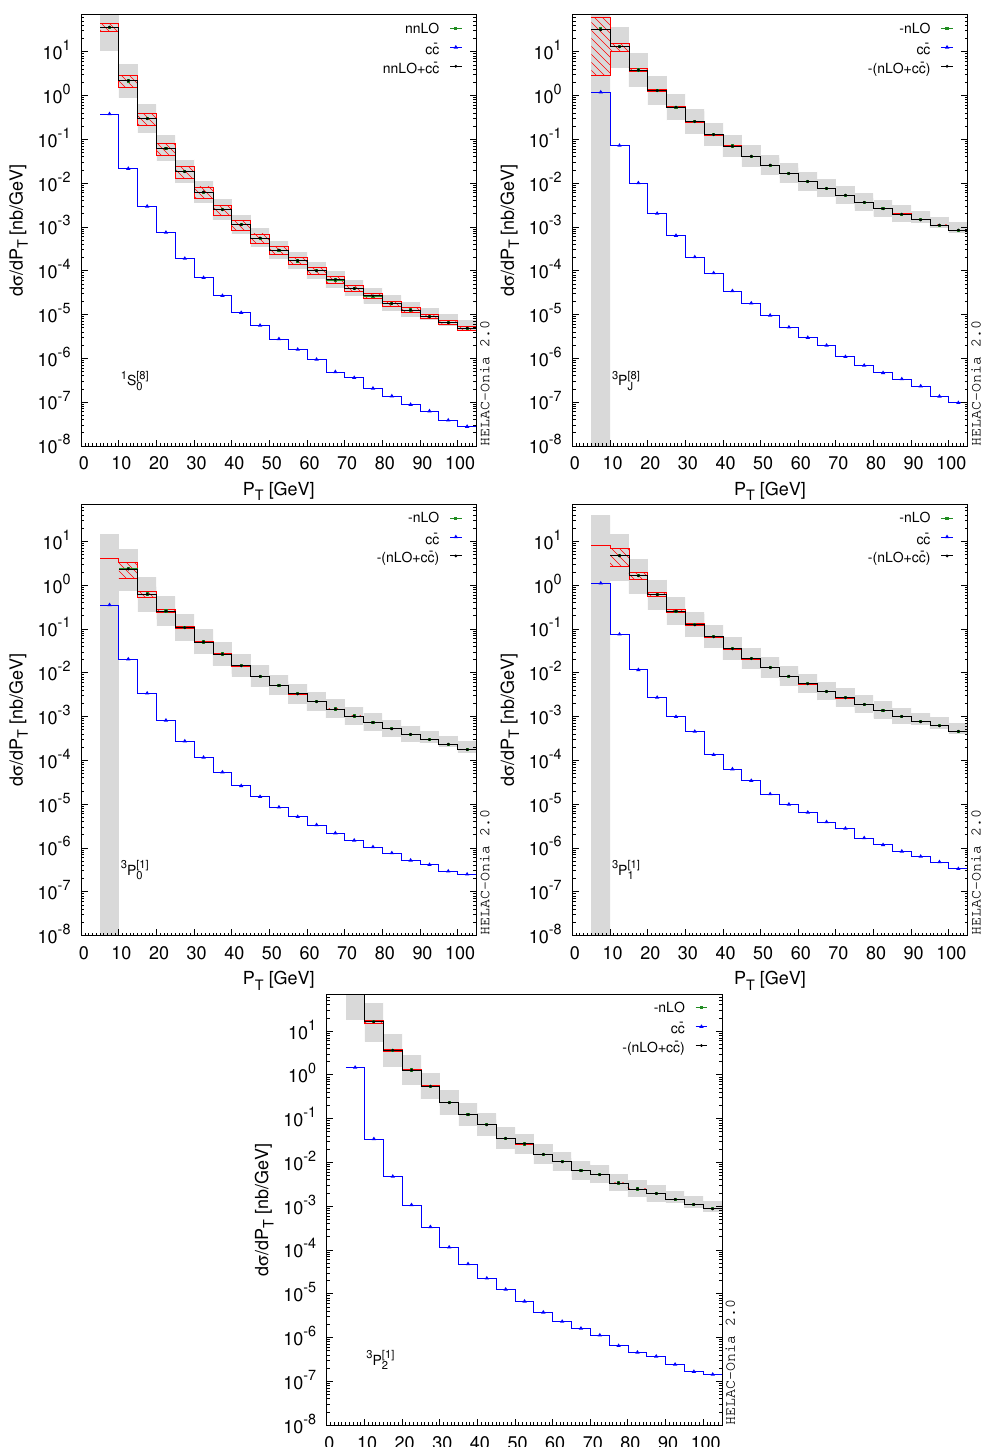
Figure 24 . Comparisons of spin-summed differential cross sections d(cid:27) 1 S [8] between our nLO calculations and the LO charmonium plus charm quark ; 3 P [8] ; 3 P [1] ; 3 P [1] ; 3 P [1] 0 0 1 2 J pair calculations. They are similar to figure